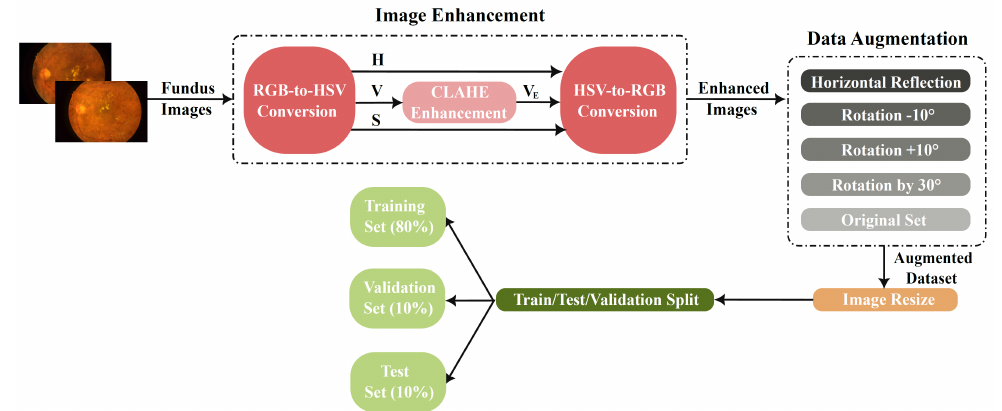
Figure 5. Data pre-processing stage for the IDRiD fundus images in Experiment 1.